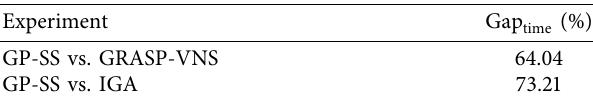
Table 9: The computing time of each m.